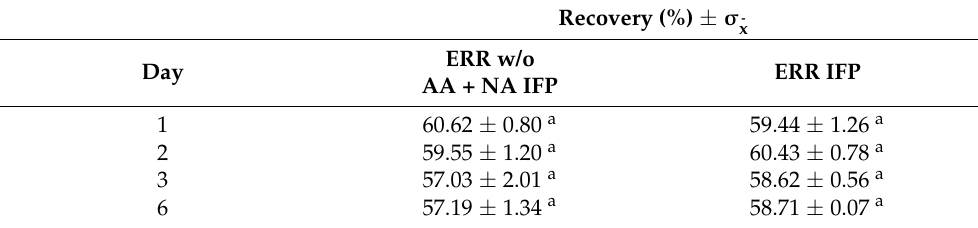
Table 2. Recovery of chemicals from ERR w/o AA + NA IFP and ERR IFP after 1–6 days of IFP curing/drying.